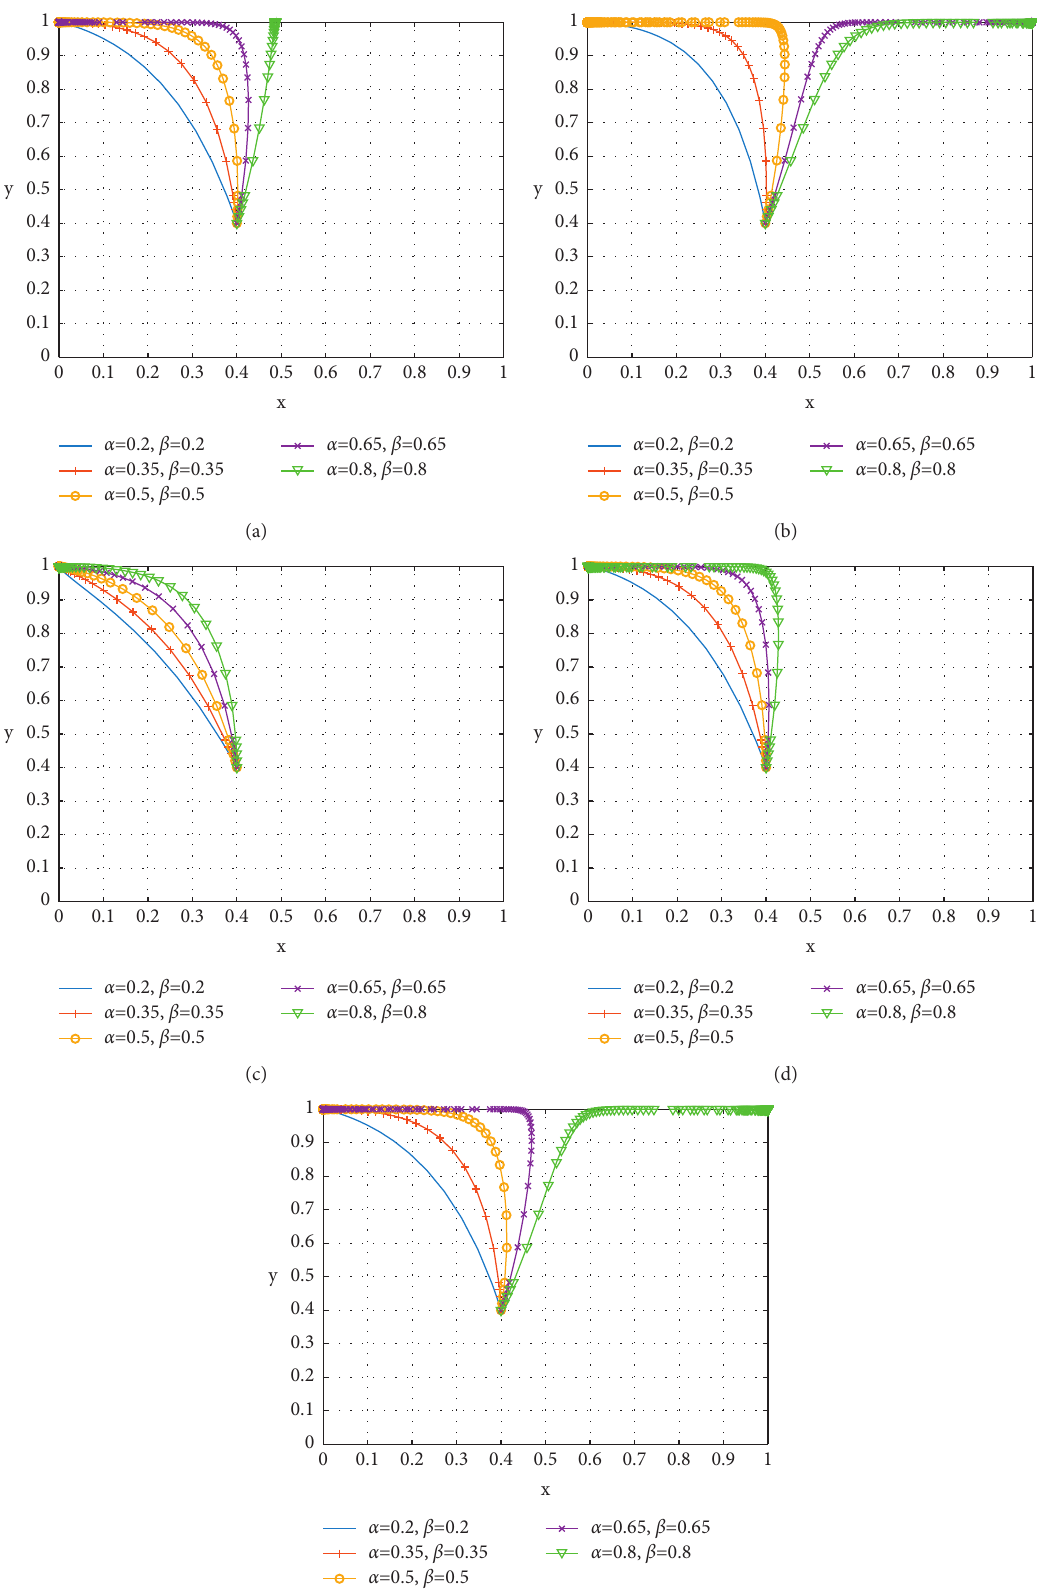
Figure 10: Evolution results with the change of α and β by the initial values in Case 3. (a) A (c) A p � 1 , A s � 1. (d) A p � 1 , A s � − 1. (e) A p � − 1 , A s �